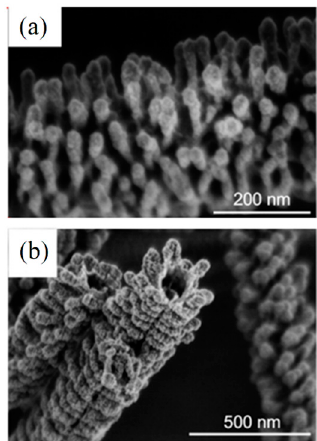
Figure 12. SEM micrographs of SnO 2 NFs. ( a ) plasma etching time of 30 s and sputtering time of 190 s; and ( b ) plasma etching time of 30 s and sputtering time of 480 s. Reprinted with permission from Ref. [116]. Copyright © 2016 Elsevier Ltd.